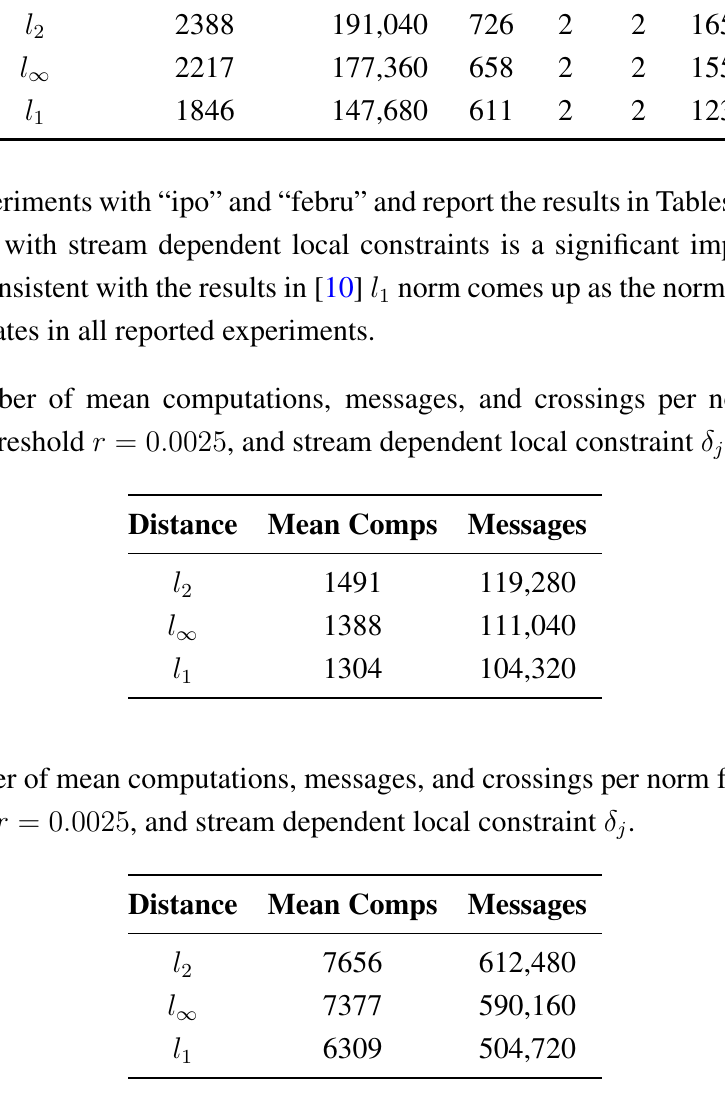
Table 3. number of mean computations, messages, and crossings per norm for feature “bosnia” with threshold r = 0 . 0025 , and stream dependent local constraint δ